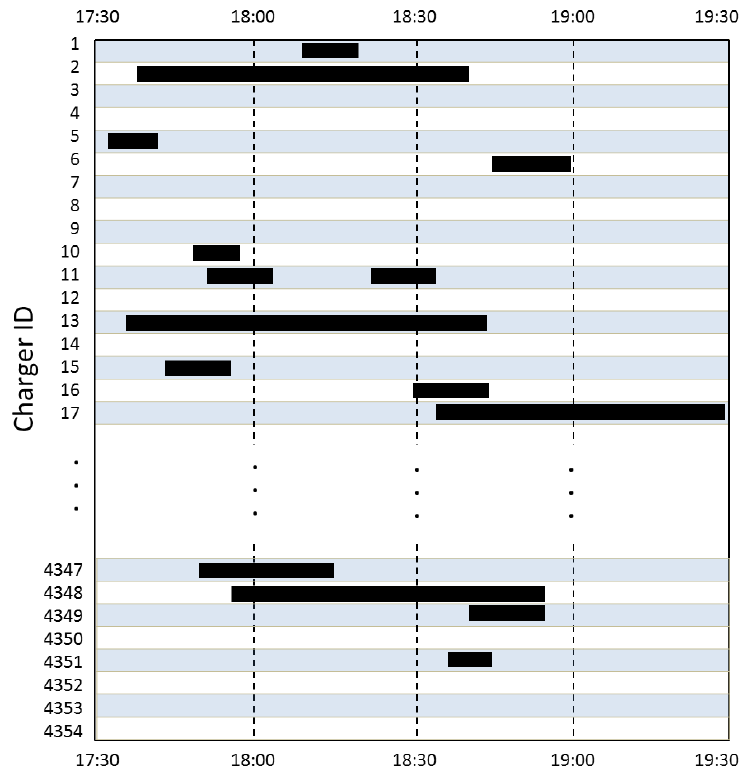
Figure 7. EV charging simulation example using Monte Carlo simulation.